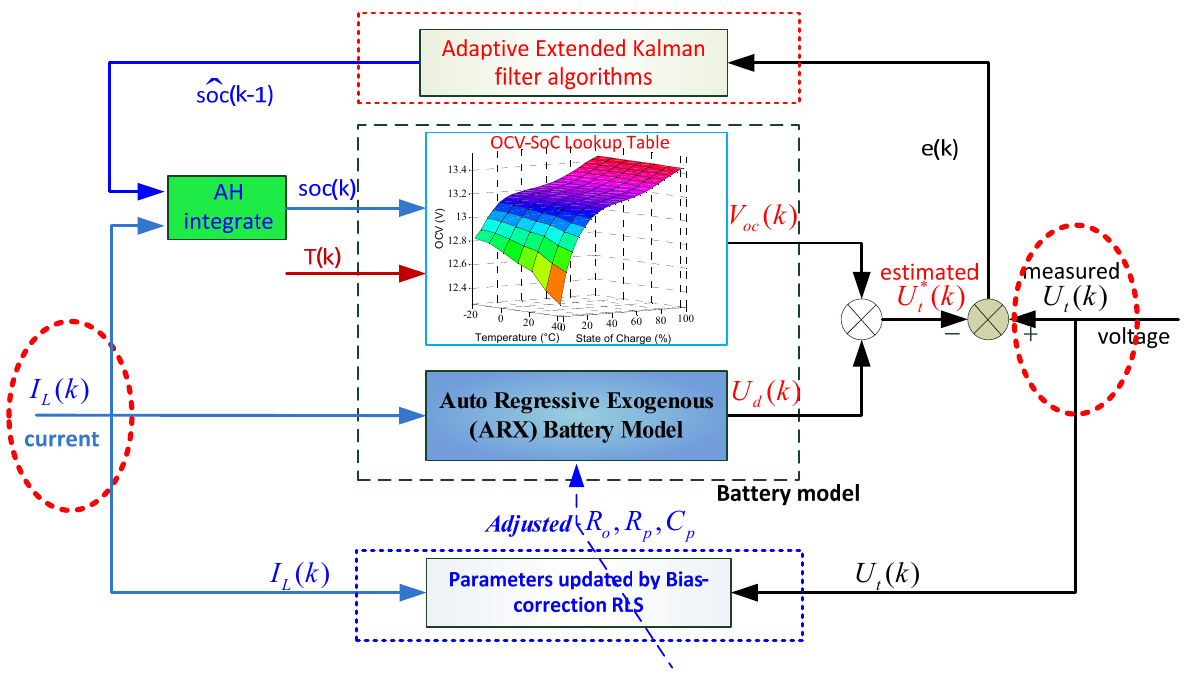
Figure 3. General diagram of the battery model parameters and SoC joint estimation with adaptive extended Kalman filter (AEKF) and correction recursive least square (CRLS)